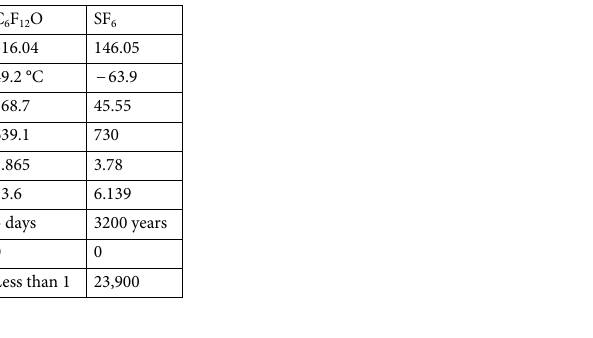
Table 1. Basic parameters of C 6 F 12 O.